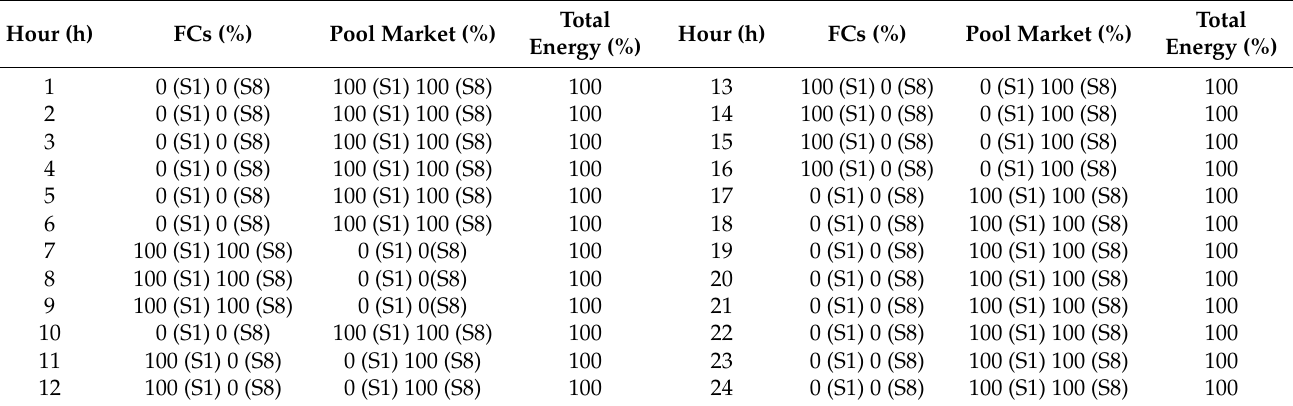
Table 10. Contribution of the two procurement mechanisms for S1 and